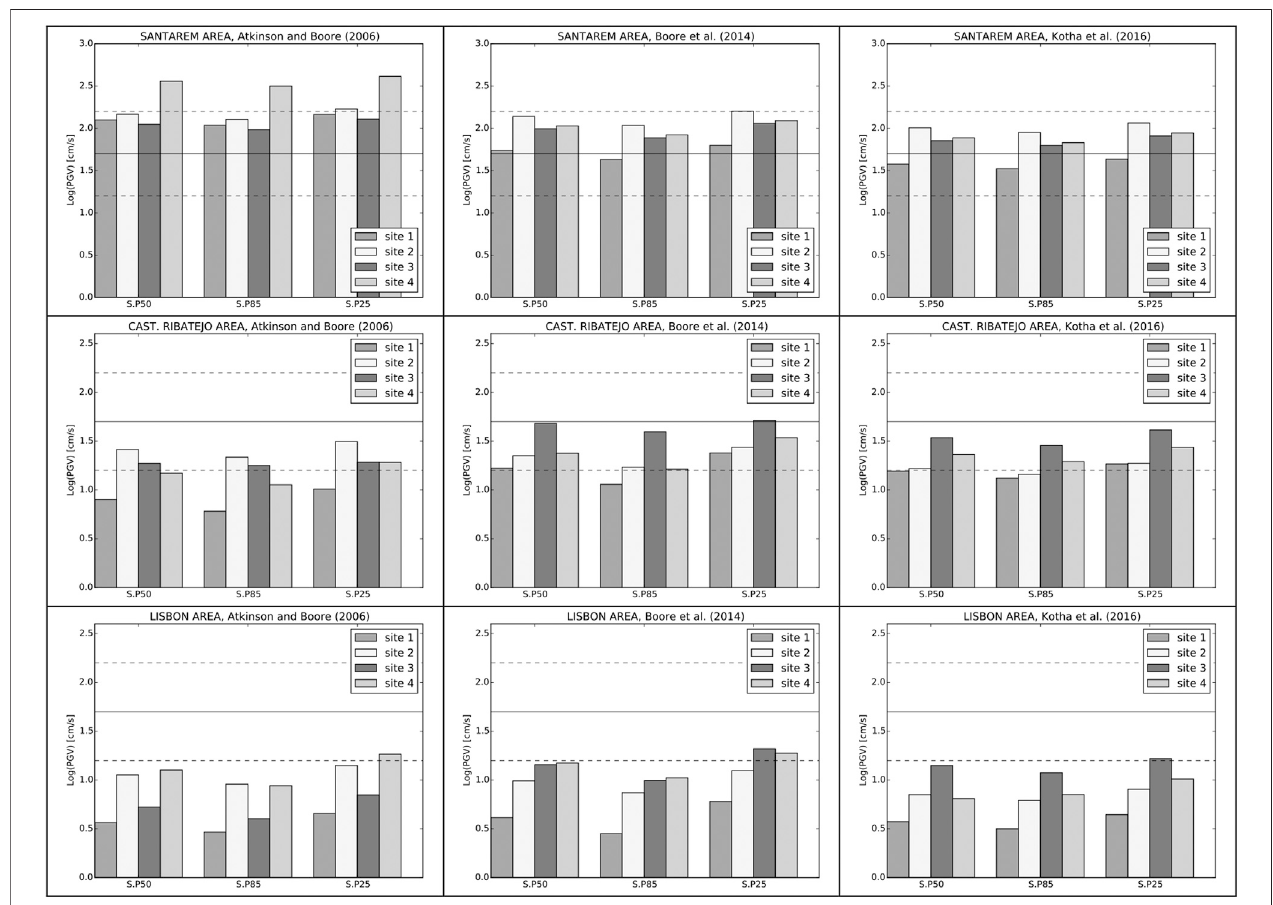
FIGURE 12 | Geographic distributions of PGV values predicted by the M7.0 scenario for the localities of Santarém, Castanheira do Ribatejo, and Lisbon by the ground motion models analyzed.